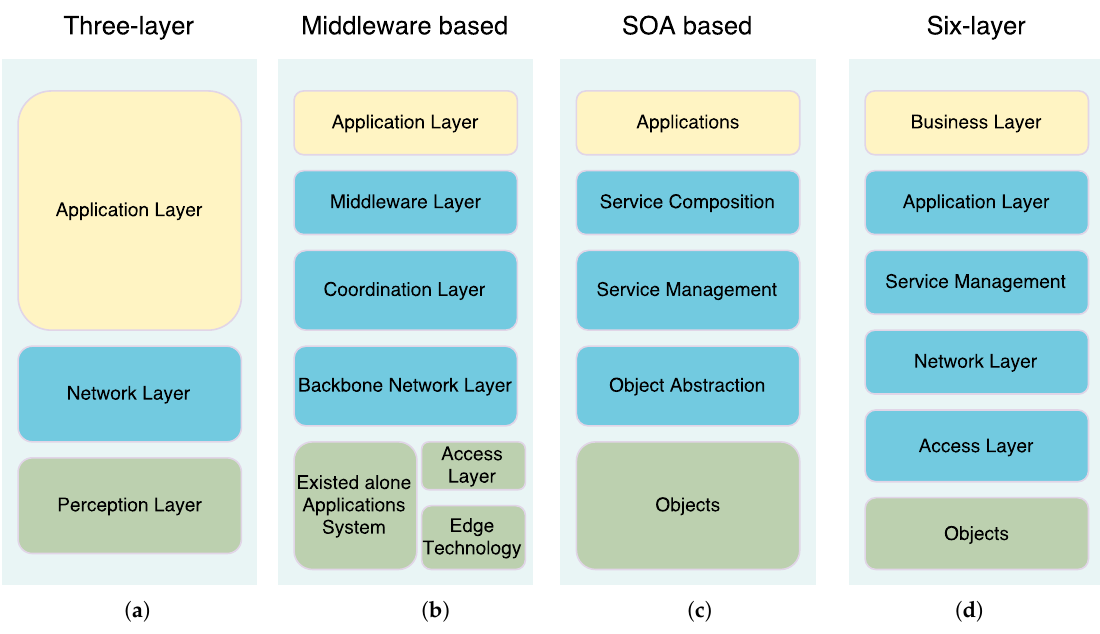
Figure 11. The IoT architecture. ( a ) Three-layer; ( b ) Middleware-based; ( c ) Service-Oriented Architecture (SOA)-based; ( d )